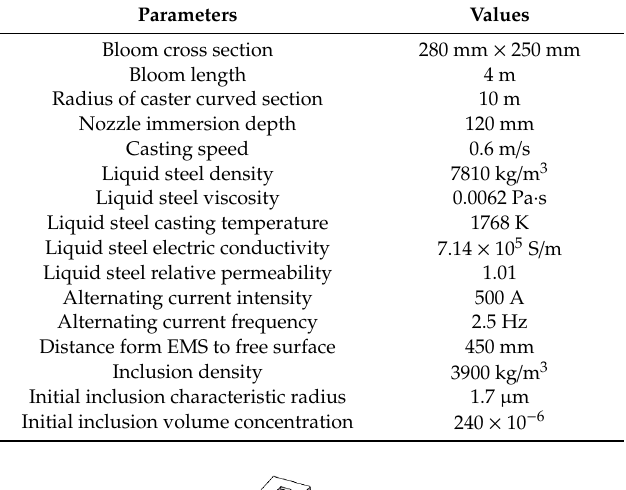
Table 2. Geometric and physical parameters.